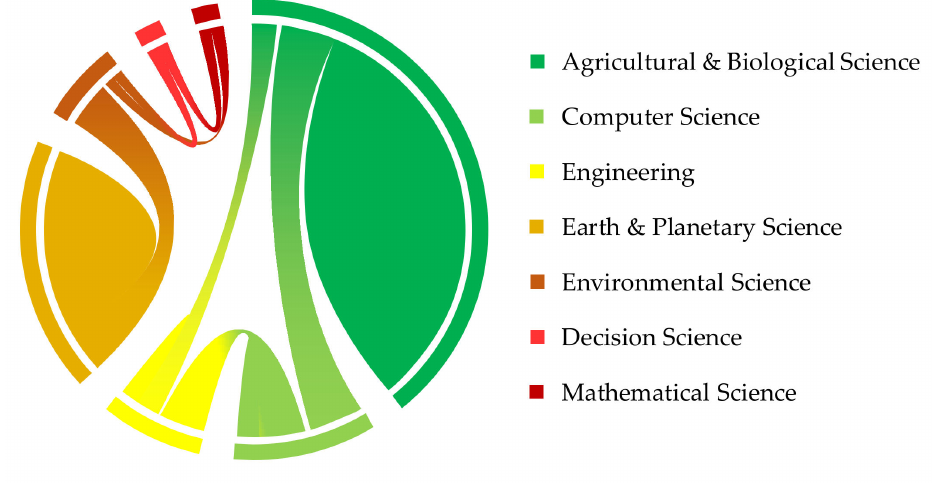
Figure 6. Inter-relationships between fields of research in UAVs for